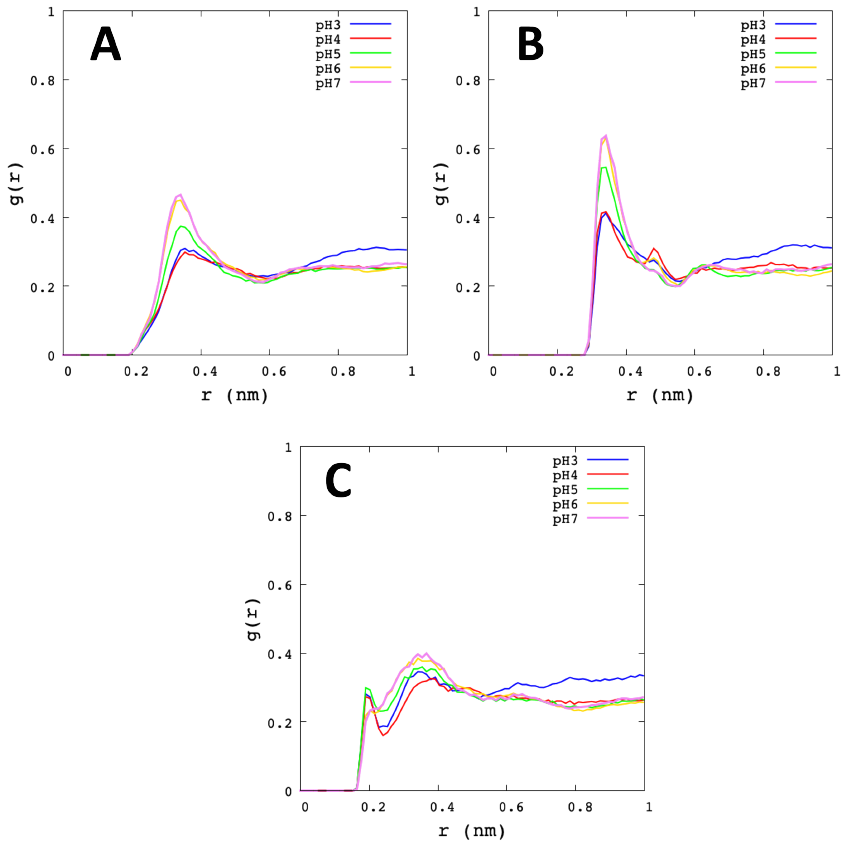
Figure 7. Radial distribution function of Cys145. The graphs show the average value of the Mpro protomers and the different microstates for each pH. ( A ) S γ –H ω . ( B ) S γ –O ω . ( C ) H γ –O ω